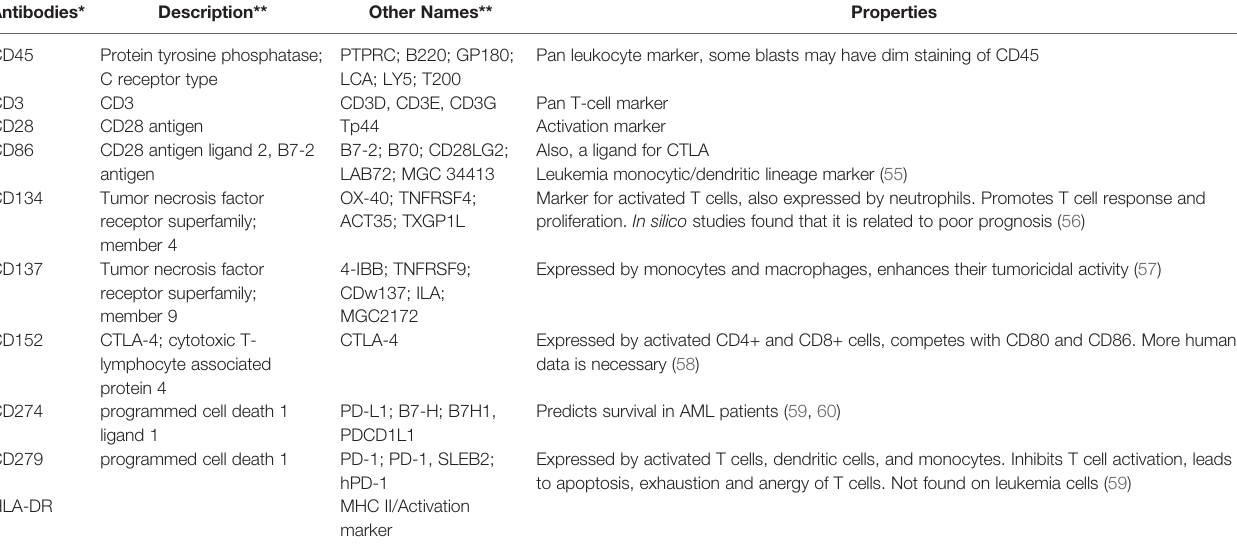
TABLE 3 | Panel for detection of immune checkpoint